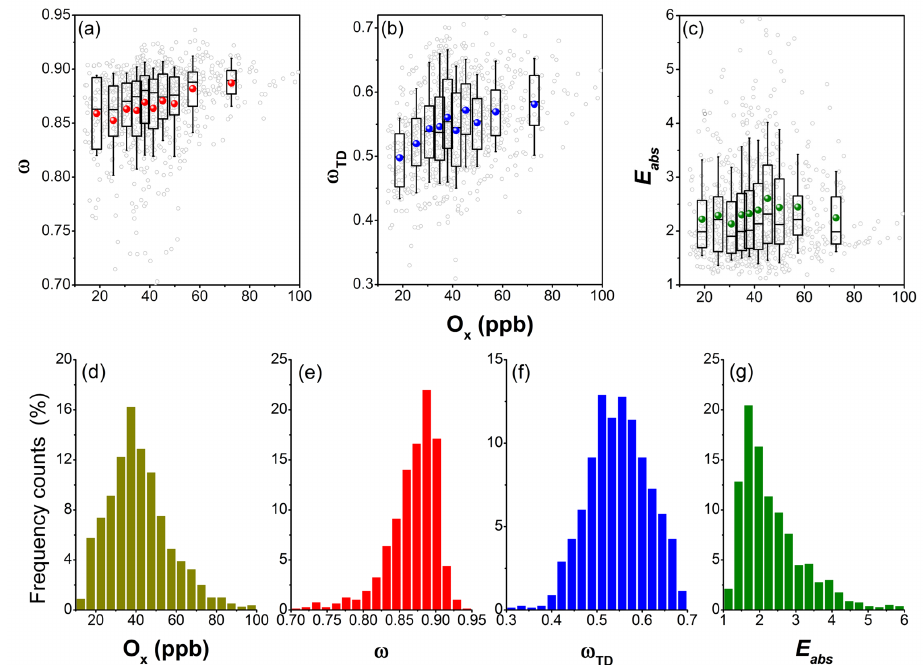
Figure 6. Relationship between (a) ω , (b) ω TD , and (c) E abs with O x concentrations. The gray circles are the measurement data with 1h time resolution. The hourly averaged ω , ω TD , and E abs were then binned in O x with the same data points (80 points) in each bin. The corresponding mean (solid dot), median (centre solid line), lower and upper quartile (boxes), and 10th and 90th percentile (whisker) are shown as the box and whisker plots. The corresponding frequency distribution of each parameters is shown in (d) – (g) .